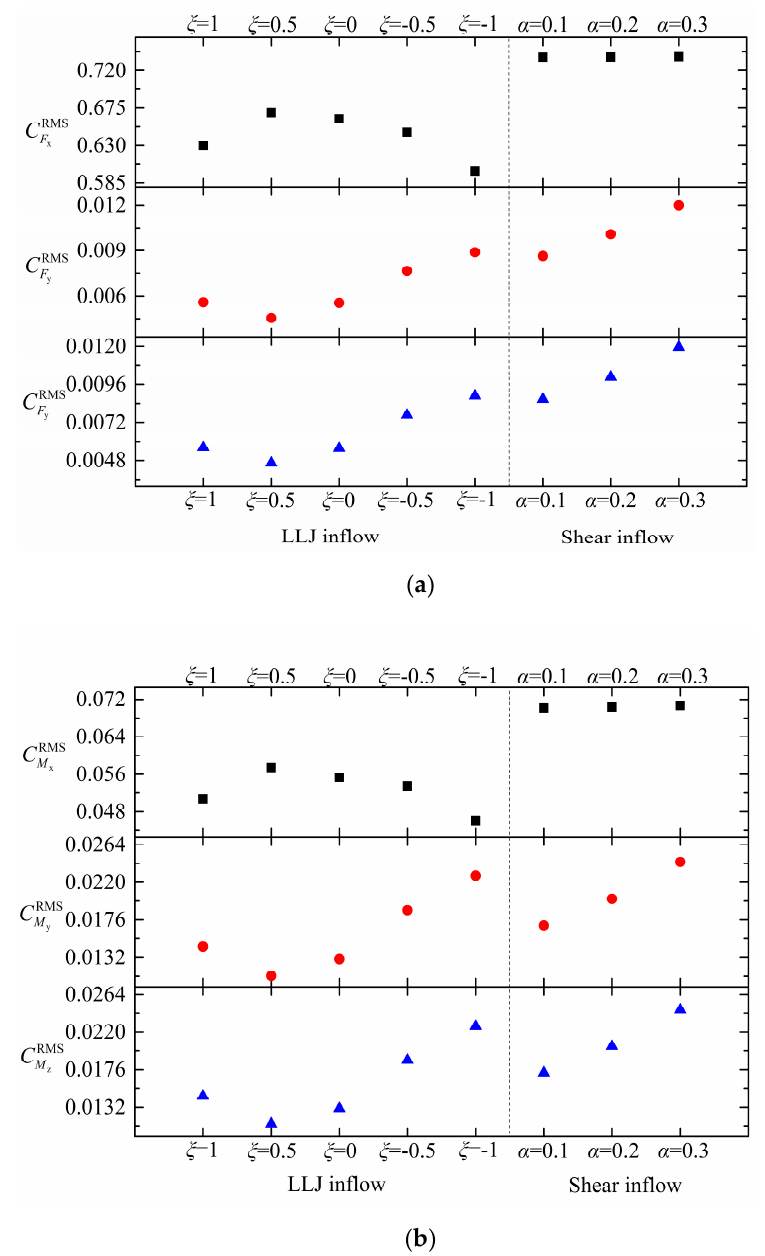
Figure 9. The RMS rotor ( a ) force coefficient and ( b ) moment coefficient under different inflow conditions.